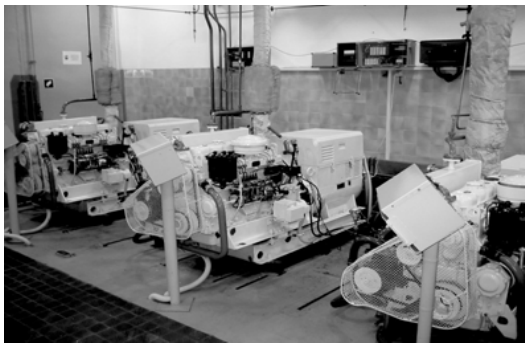
Figure 2. General view of the laboratory with ZE-400 generating sets.